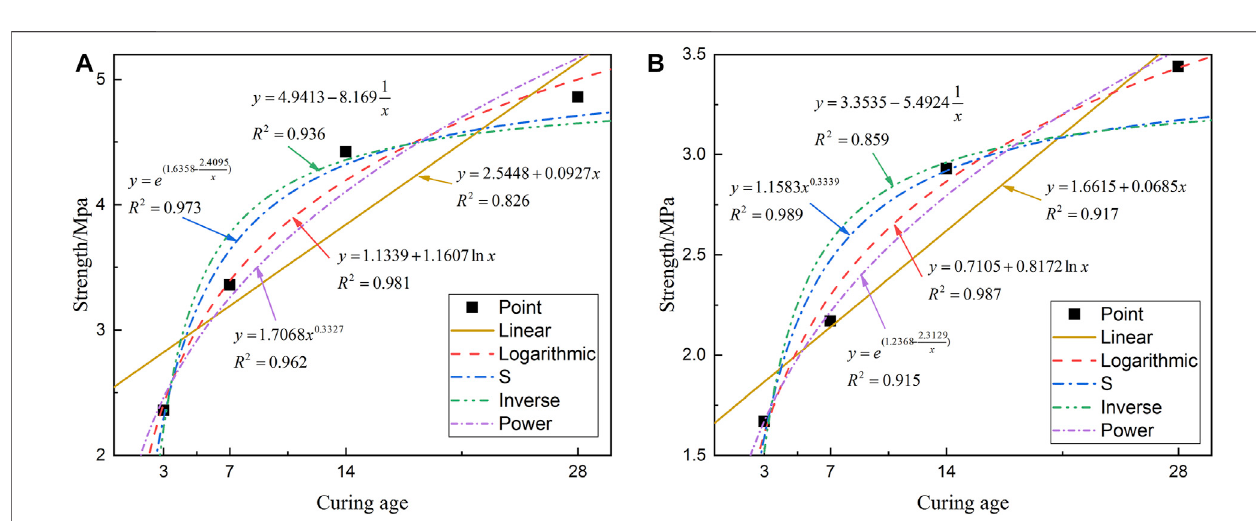
FIGURE 6 | Fitting curve and regression equation of UCS with curing age: (A) C/T ratio 1:6; (B) C/T ratio 1:4.